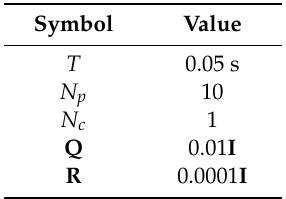
Table 1. Parameters in all controllers.